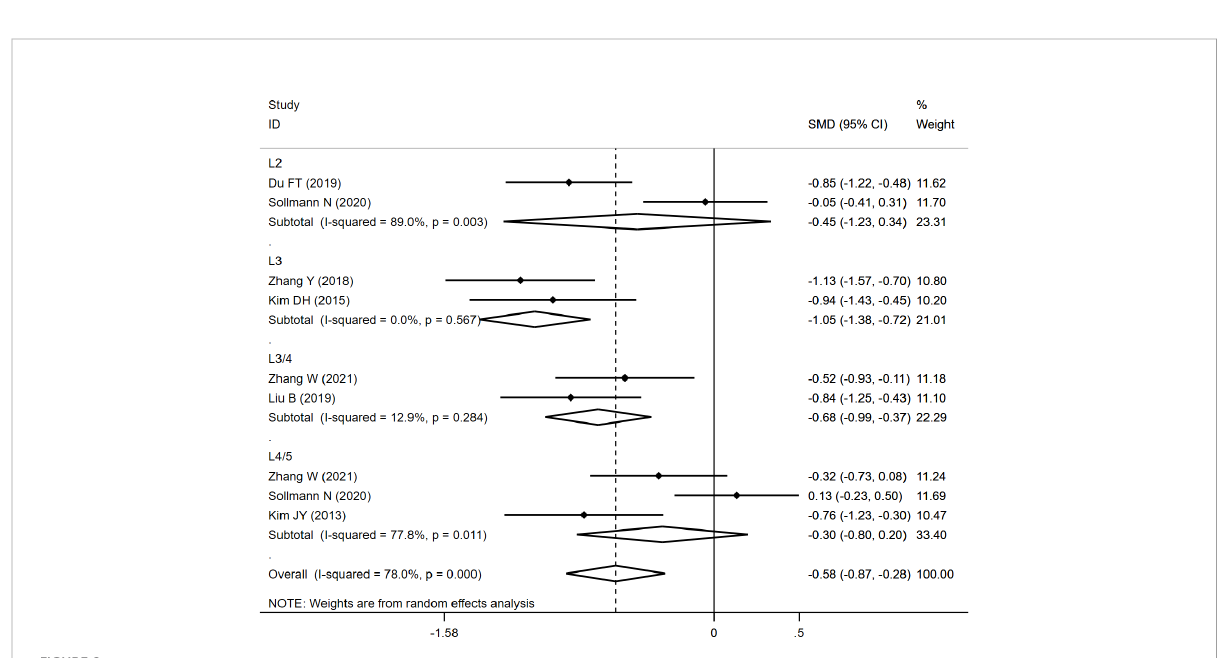
FIGURE 2 Forest plot of the CSA ES+MF comparing the fracture group with the non-fracture group.